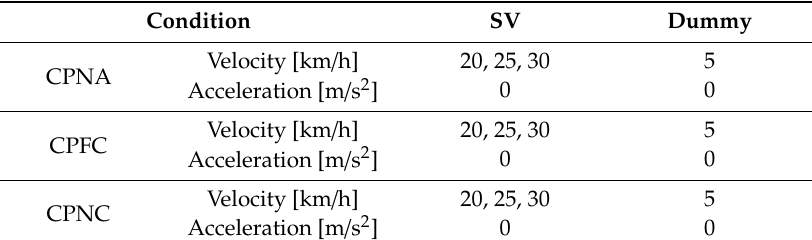
Table 1. AEB pedestrian scenario test conditions.